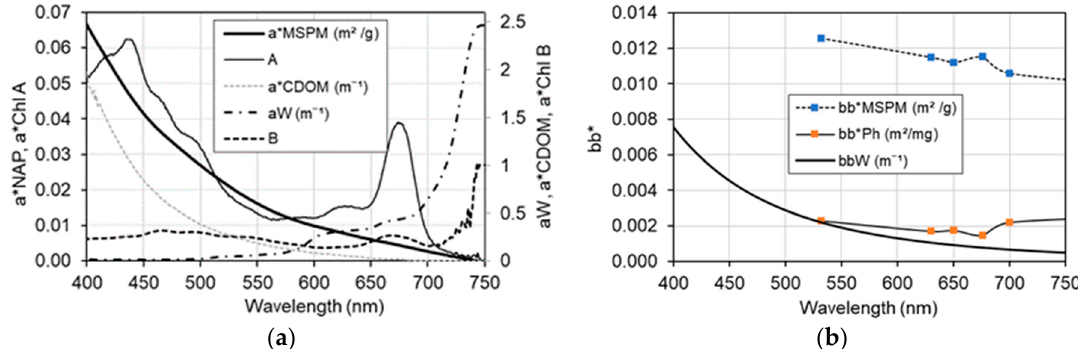
Figure 1. The average concentration-specific inherent optical properties (SIOPs) used in Ecolight for reflectance simulations: ( a ) concentration-specific absorption coefficients, a*, and ( b ) concentration-specific backscatter coefficients, b b *. A and B in ( a ) are coefficients of a* Ph defined in Equation (3).